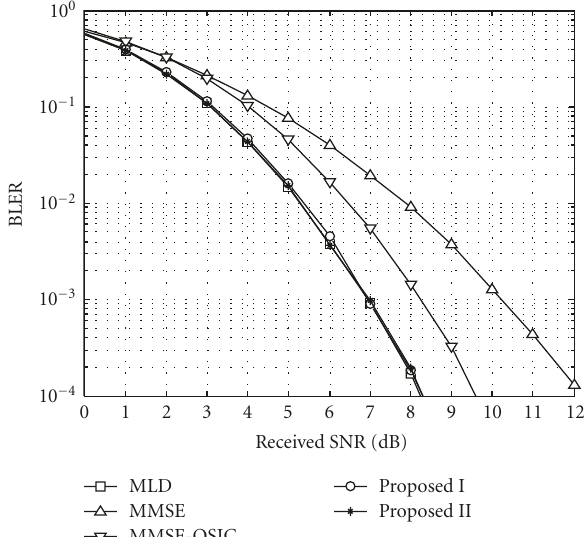
Figure 8: Comparison of the BLER performance of the first PSS for the proposed and the conventional schemes when both MSs transmit with (16QAM, 1/2).